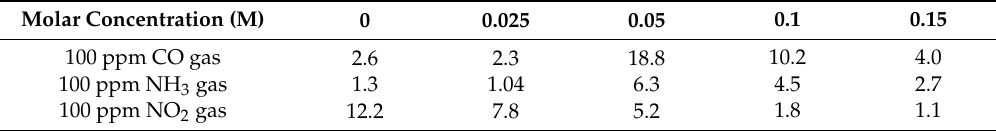
Table 2. Response at various concentrations of α -Fe 2 O 3 at 300 ◦ C.